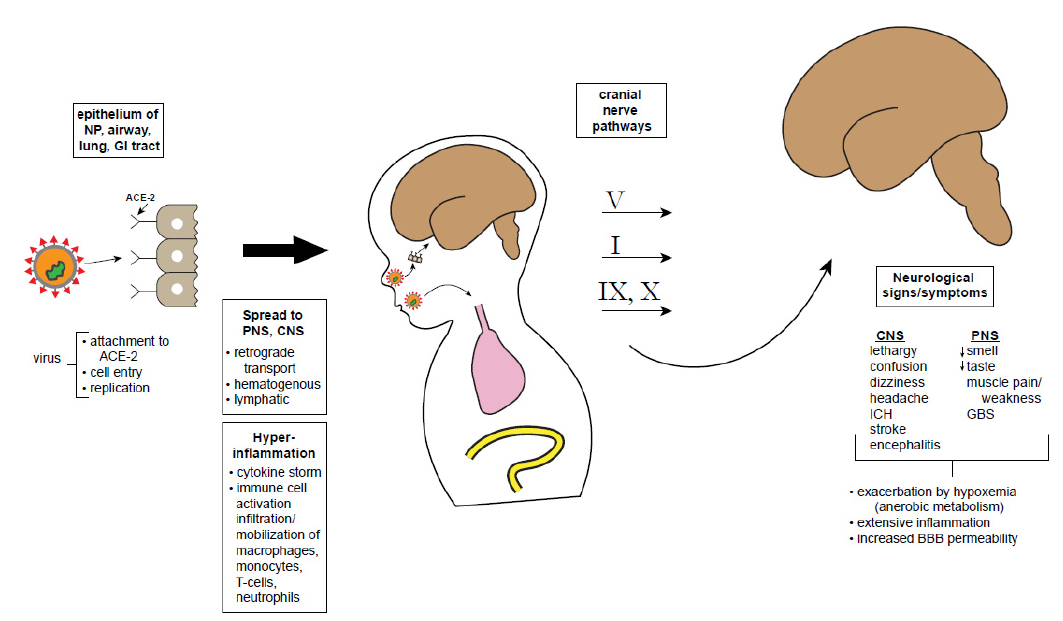
Figure 1. Schematic showing possible CNS entry points and e ff ects of SARS-CoV-2. The SARS-CoV-2 virus attaches to olfactory epithelium using the ACE-2 receptor. After cell entry, the virus replicates and induces a massive immune response leading to excessive cytokine release, comprising a maladaptive immune response. Theoretically, virus particles may reach the CNS retrogradely via cranial nerve pathways: V from corneal epithelium or oropharyngeal cutaneous sensory receptors; I via the cribiform plate, infecting olfactory sensory neurons; VII and IX from tongue chemoreceptors; X via pulmonary mechanoreceptors. Once reaching CNS nuclei including brainstem and cortex, a variety of neurologic signs and symptoms are possible. However, it must be noted that the virus has not been recovered from CSF or brain tissue, making all of these pathways hypothetical at this point.